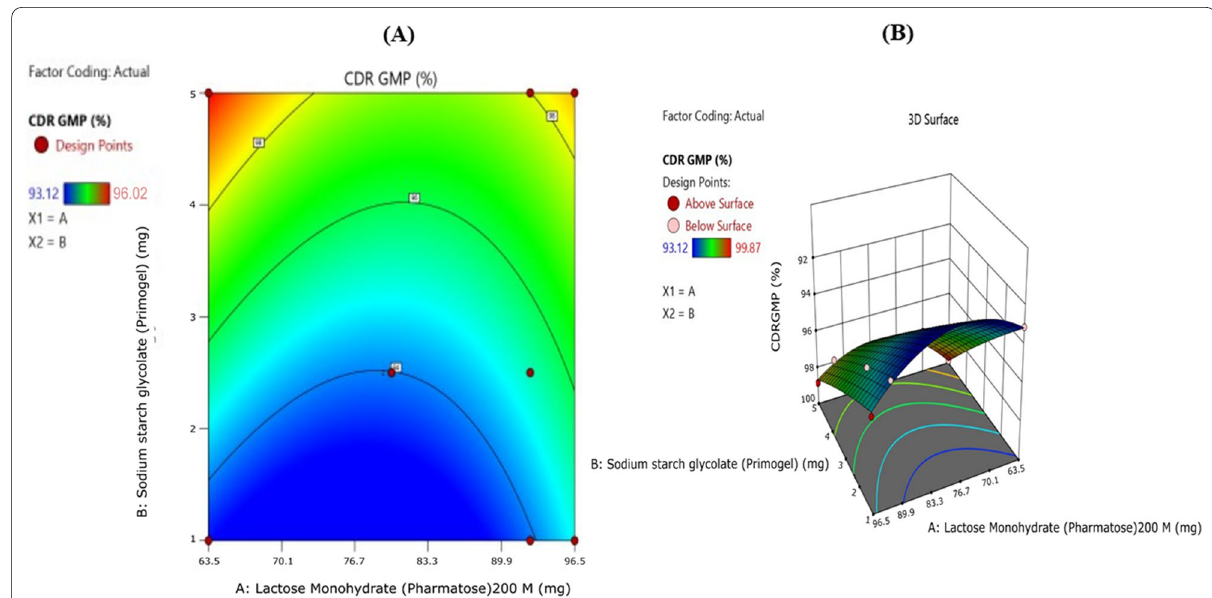
Fig. 5 A Contour plot and B Response surface plot for dependent variables of GMP-IR pellets with %CDR as a response